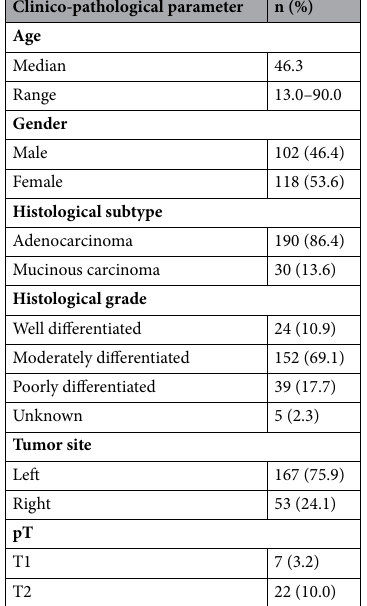
Table 1. DNA isolation. DNA samples were extracted from formalin-fixed and paraffin-embedded (FFPE) CRC